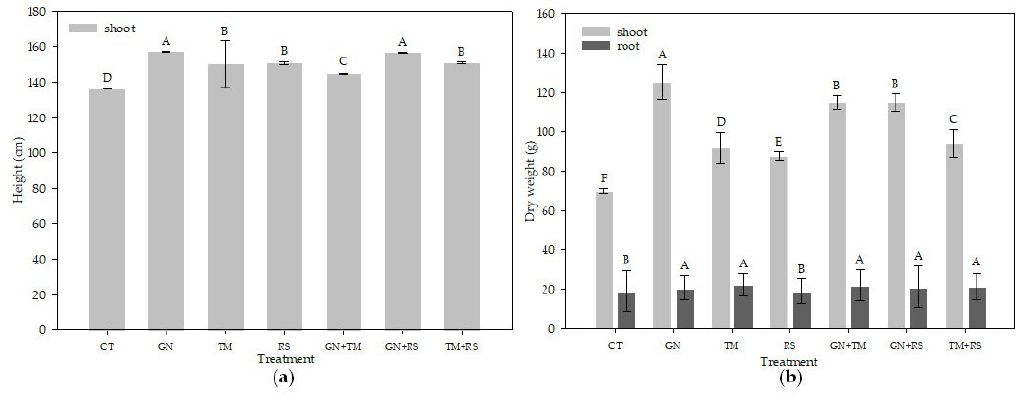
Fig. 3. Plant height (a), and root dry weight and shoot dry weight (b) of maize at 56 days after planting activity in soil treated with different quality organic (CT: untreated control, GN: groundnut, TM: tamarind, RS: rice straw, GN+TM: groundnut + tamarind, GN+RS: groundnut + rice straw, TM+RS: tamarind + rice straw). Means for the same character with the same letter (lower case) are not significantly different by LSD at 0.05 probability